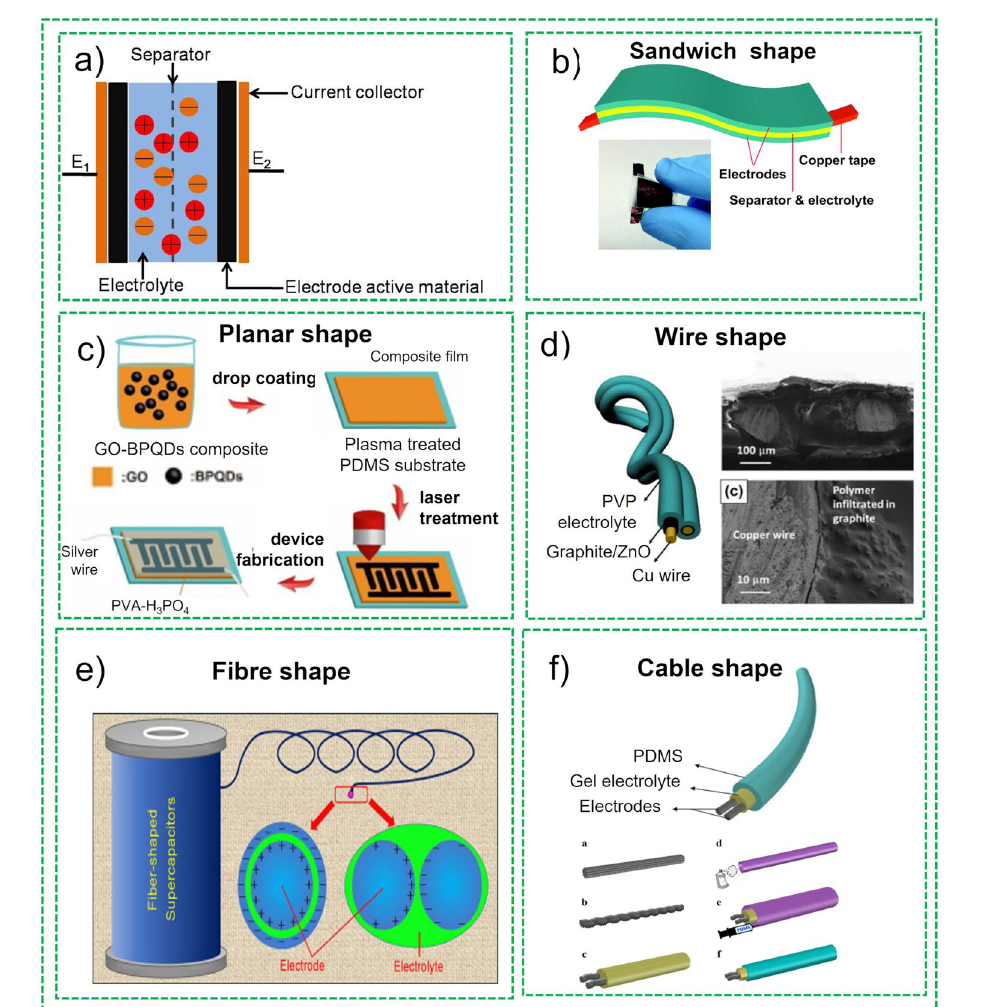
Fig. 9 a Typical structure of the supercapacitors, b Sandwich shape supercapacitors. Reprinted with permission from Ref. [89]. c Planar shape supercapacitors. Reprinted with permission from Ref. [90]. d Wire shape supercapacitors. Reprinted with permission from Ref. [77]. e Fiber shape supercapacitors. Reprinted with permission from Ref. [91]. f Cable shape supercapacitors Reprinted with permission from Ref.